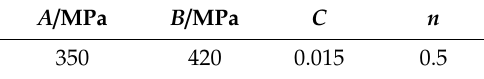
Figure 12. Distributions of the residual stresses along the depth by the Johnson–Cook and the constitutive models. proposed constitutive models. Table 3. Parameters of the Johnson–Cook